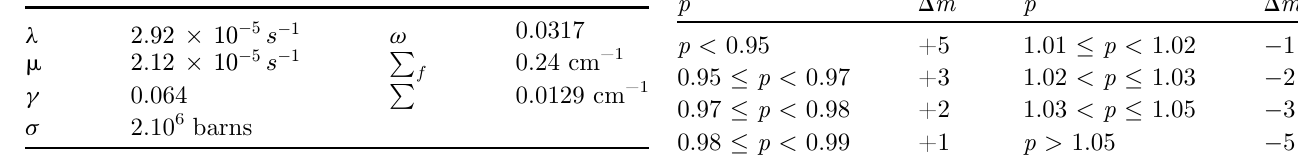
Table 2. Typical values for the parameters introduced in our model.